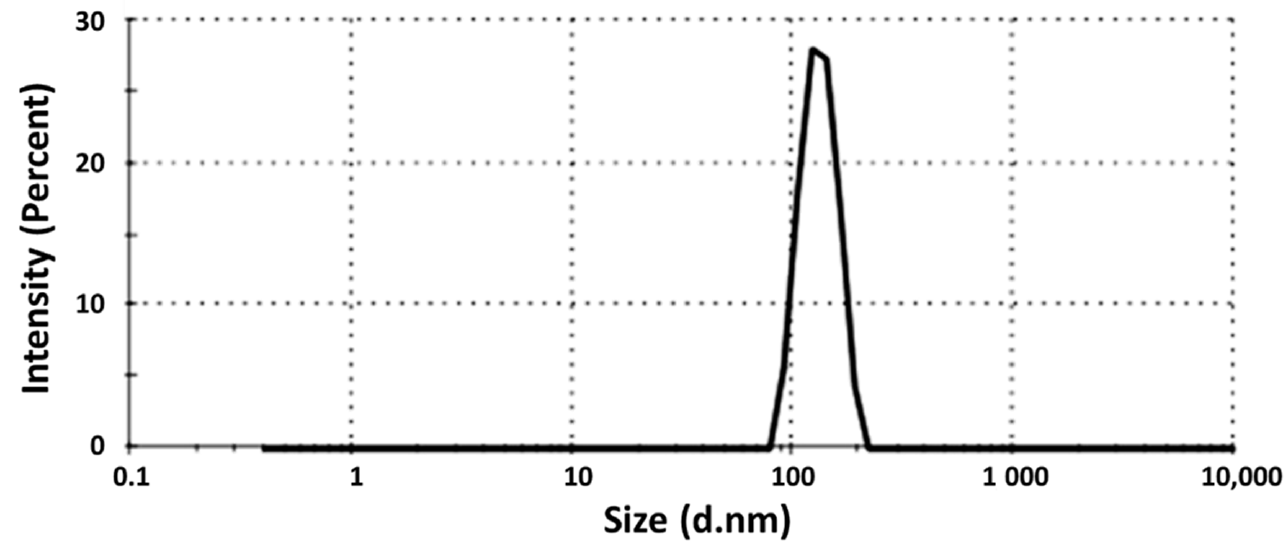
Figure 1. Particle size of the selected drug-loaded SEDDS.